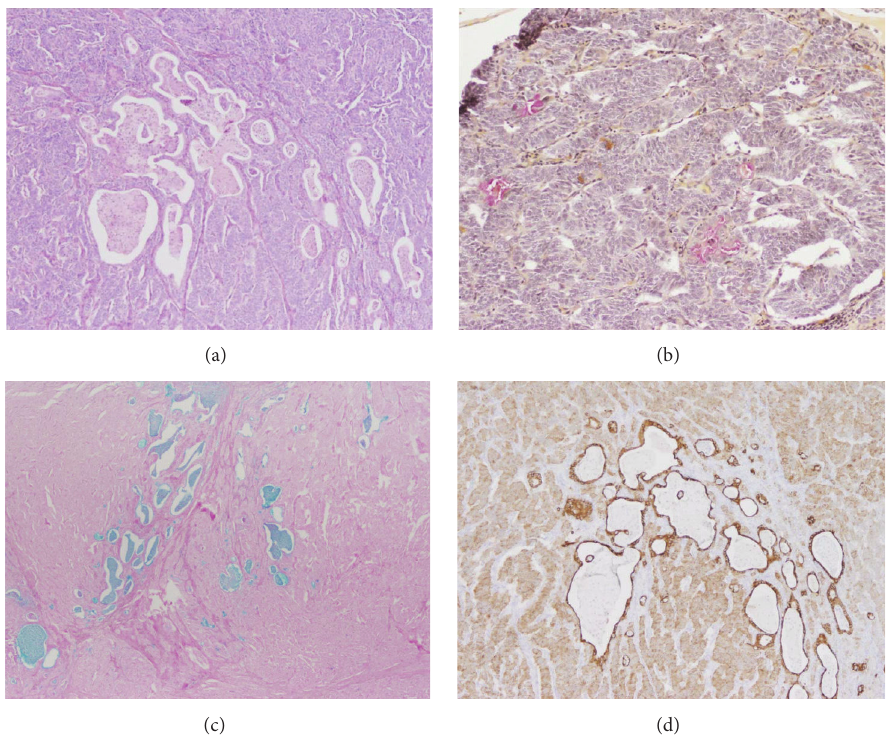
Figure 3: Metastasis to the perigastric lymph nodes: (a) intermixed neuroendocrine and glandular components (H&E, 40x). Glands are better highlighted on mucin stain (b, 100x) and Alcian Blue stain pH 2.5 (c, 40x). (d) Pancytokeratin image demonstrates stronger staining in the glandular component compared with the neuroendocrine component